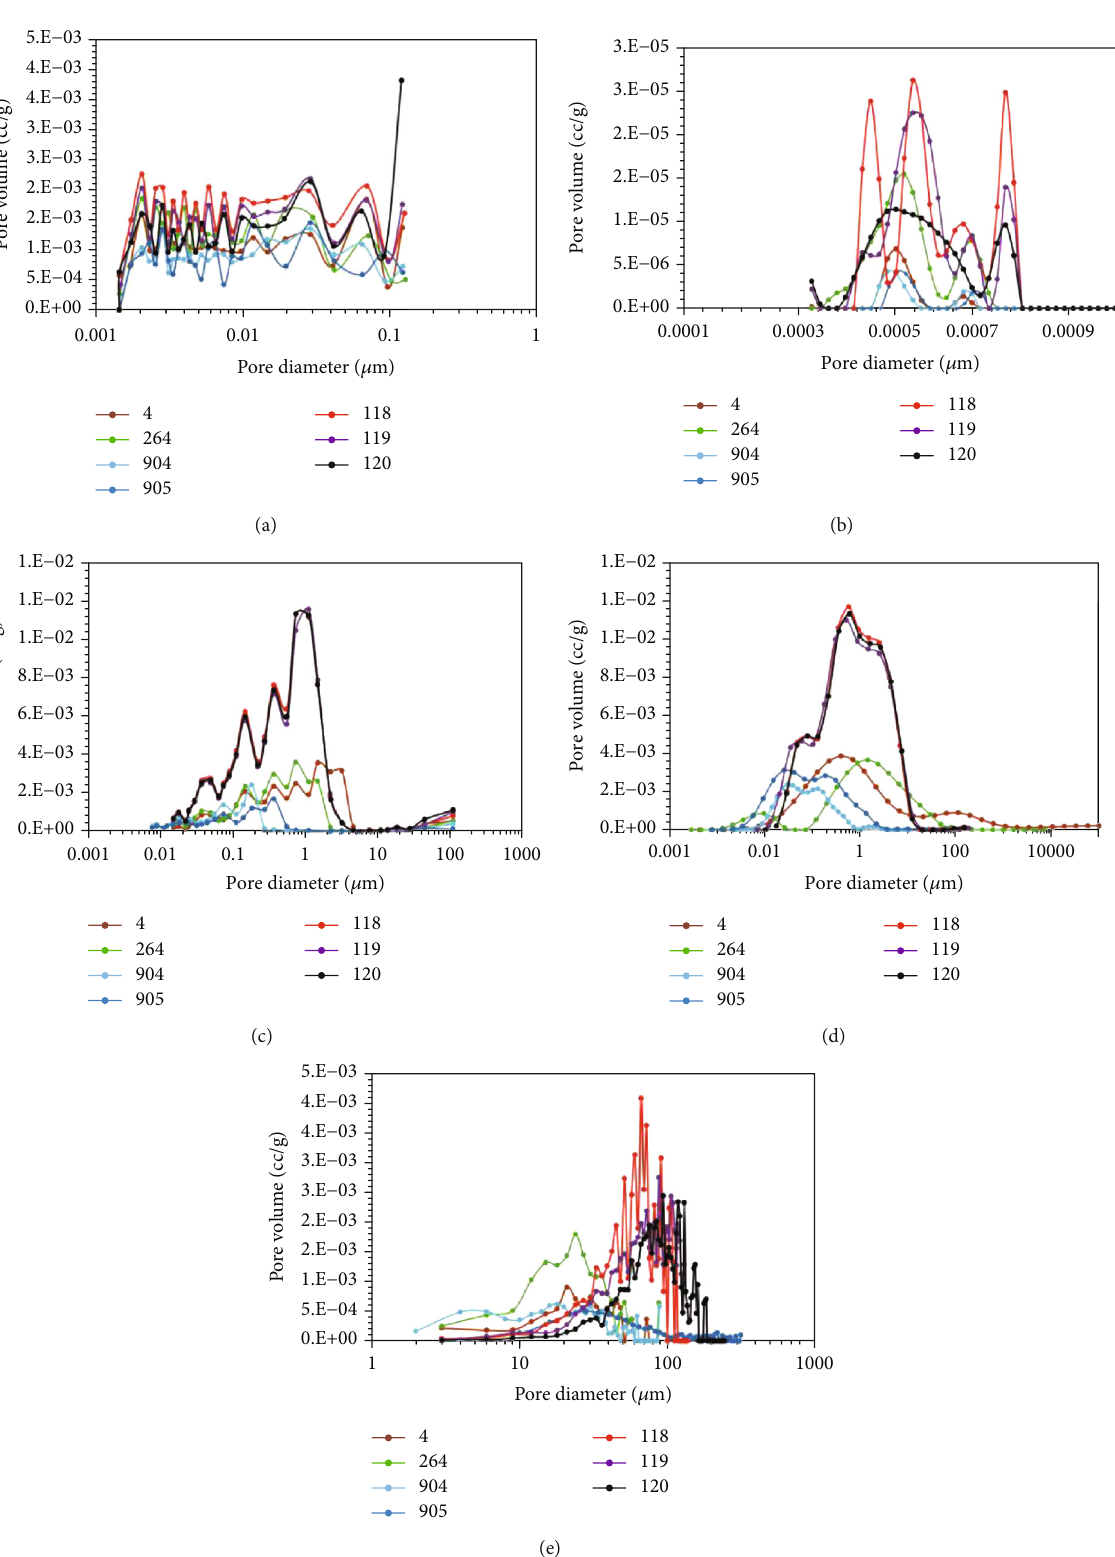
/CO -LPAI, MICP, NMR, and XCT of seven tight sandstones. (a) PSD curves 2 2 -LPAI. (c) PSD curves derived from MICP. (d) PSD curves derived from NMR. 2